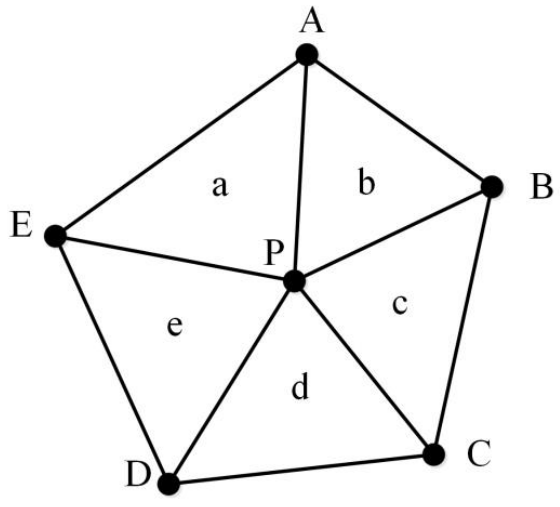
Figure 6. The minimum matching unit (MMU).